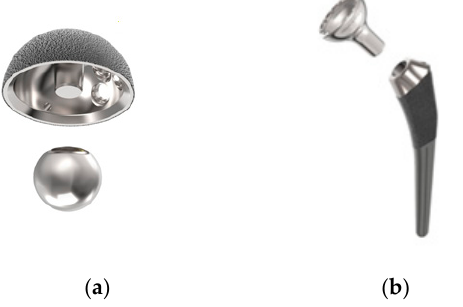
Figure 2. Test setup for corrosion evaluation via ISO 7206-6.